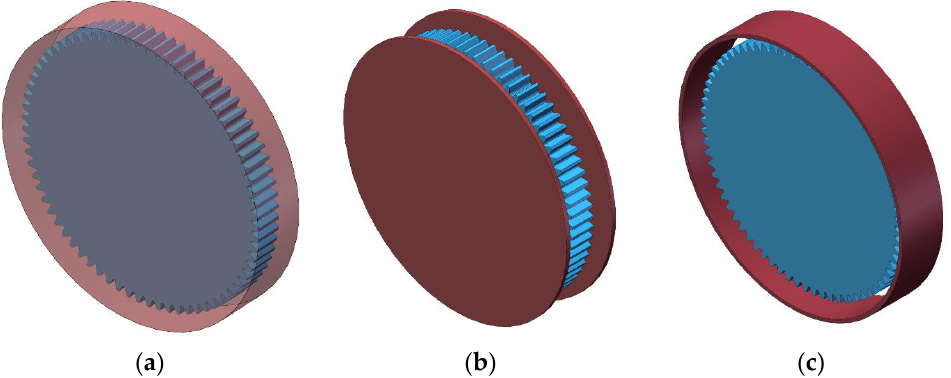
Figure 1. Computational domain and baffle settings: ( a ) Computational domain; ( b ) Axial baffle; ( c ) Radial baffle.